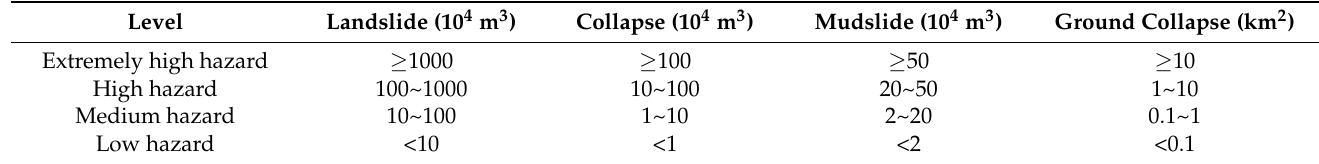
Table 1. Classification standards of geological disaster scale.